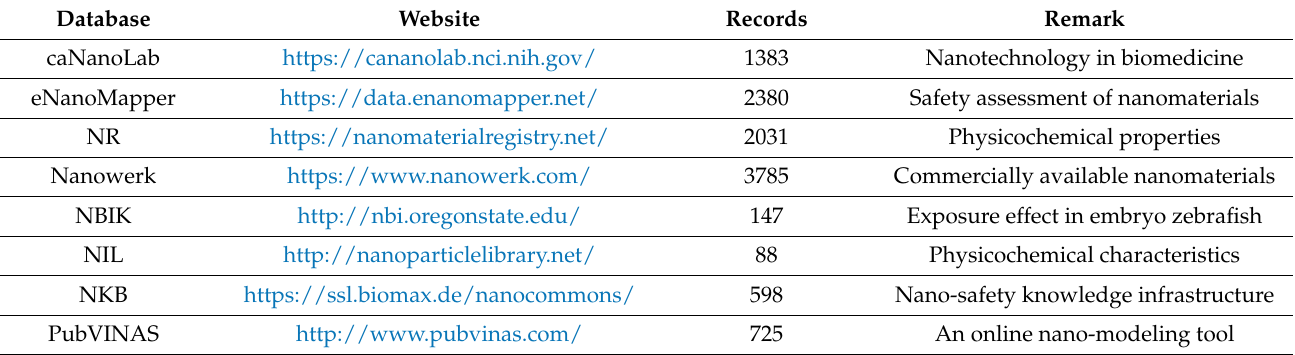
Table 1. Popular databases of nanomaterials (all the web links were accessed on 16 February 2021).